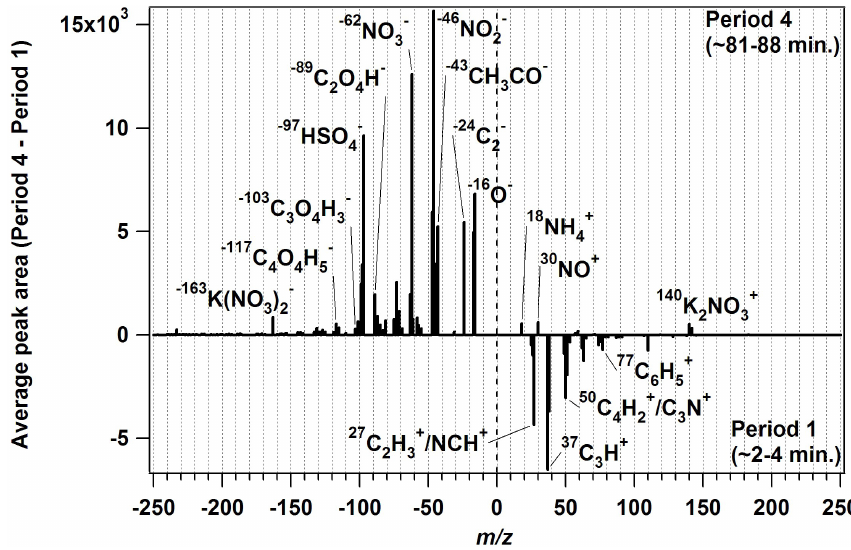
Fig. 5. A-ATOFMS average positive and negative ion mass spectra for biomass burning particles during RF03 Period 1 (age ∼ 2–4min) subtracted from biomass burning particles during RF03 Period 4 (age ∼ 81–88min). Positive intensity ion peaks indicate species added during aging of the individual biomass burning particles; negative intensity ion peaks indicate species with higher ion intensities within the fresh particles. Only ion peaks above 95% confidence limits following subtraction are shown.